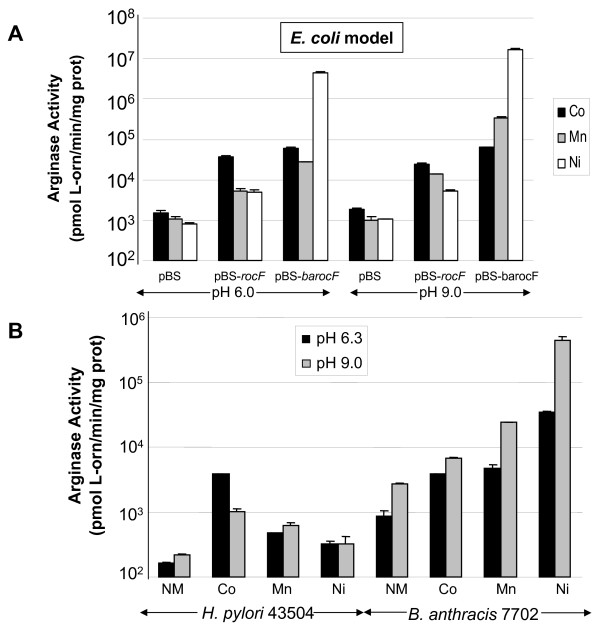
Characteristics of arginase extracts from E. coli DH5α expressing the H. pylori or B. anthracis enzymes or from native organisms. Extracts were prepared from E. coli carrying H. pylori (pBS-rocF) or B. anthracis rocF (pBS-barocF) and grown in L broth at 37°C with aeration (A) or from 24 hour cultures of B. anthracis and H. pylori grown on CBA at 37°C in 10% CO2, 5% O2 (B). Extracts were heat-activated for 30 minutes at 50–55°C in the presence of ddH2O (no metal control), 5 mM CoCl2, MnSO4, or NiCl2 and assayed at pH 6.0 or 9.0 in MES-buffered arginine or Tris-buffered arginine, respectively (A) or at pH 6.3 or pH 9.0 in BTP-buffered arginine (B). Arginase activity data are the mean arginase activity ± standard deviation of one representative of at least two experiments (independently prepared extracts) conducted in triplicate. Under these conditions, E. coli DH5α(pBS) showed a background of ~1000 pmol L-orn/min/mg protein [U]. Lack of error bars on some bars indicates that the standard deviation was minimal and did not appear on the graph. NM, no metal.